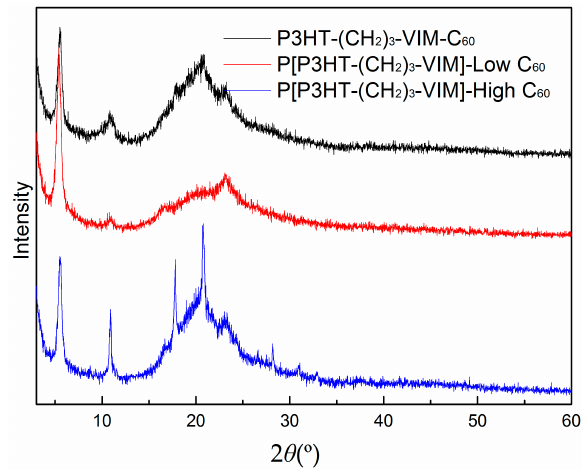
Figure 17. XRD patterns of P3HT-(CH 2 ) 3 -VIM-C 60 and P[P3HT-(CH 2 ) 3 -VIM-C 60 ].